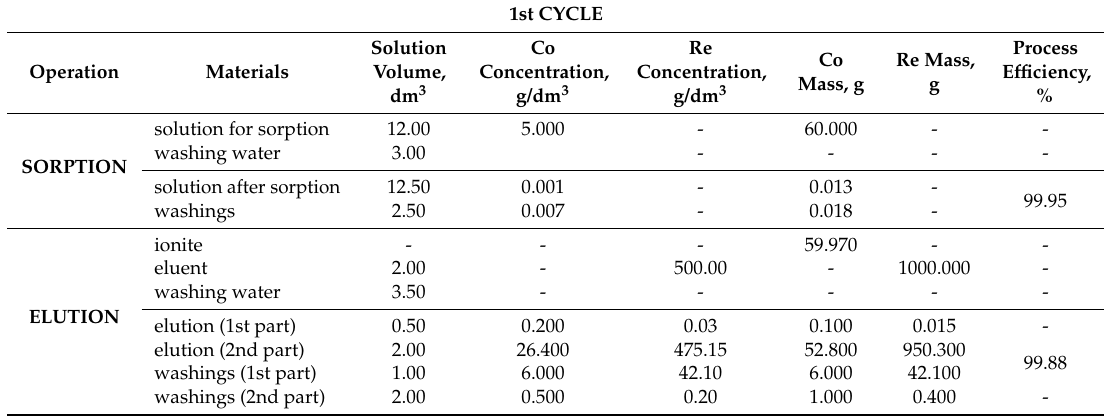
Table 8. Balance for cobalt(II) sorption and elution—1st cycle.